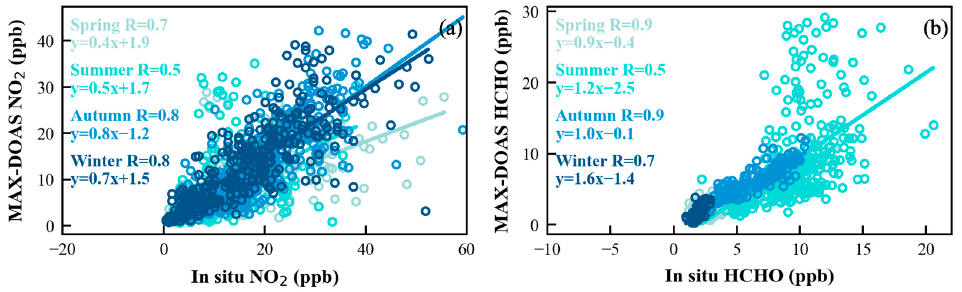
Figure 1. Correlation analysis of MAX-DOAS and in situ observations: ( a ) NO 2 ; ( b ) HCHO.